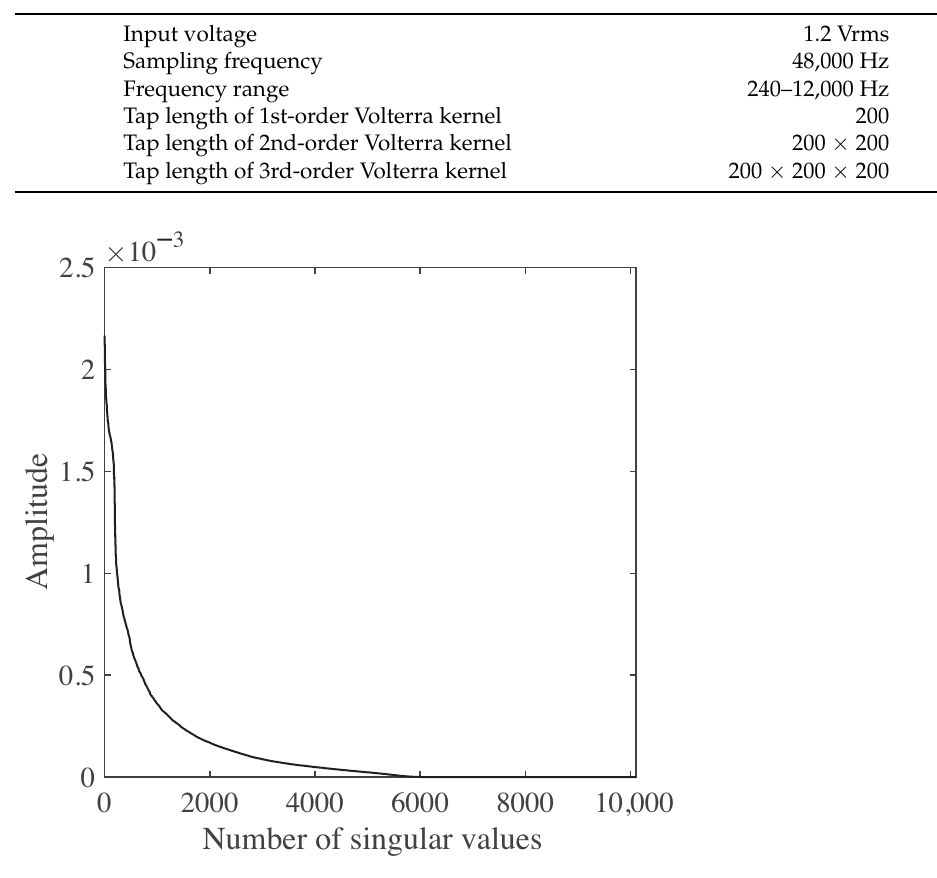
Figure 4. Distribution of singular values for the third-order Volterra kernel of the target